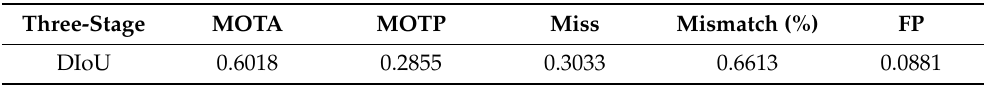
Table 6. Three-dimensional MOT three-stage association on cyclist class, Waymo Open Dataset validation